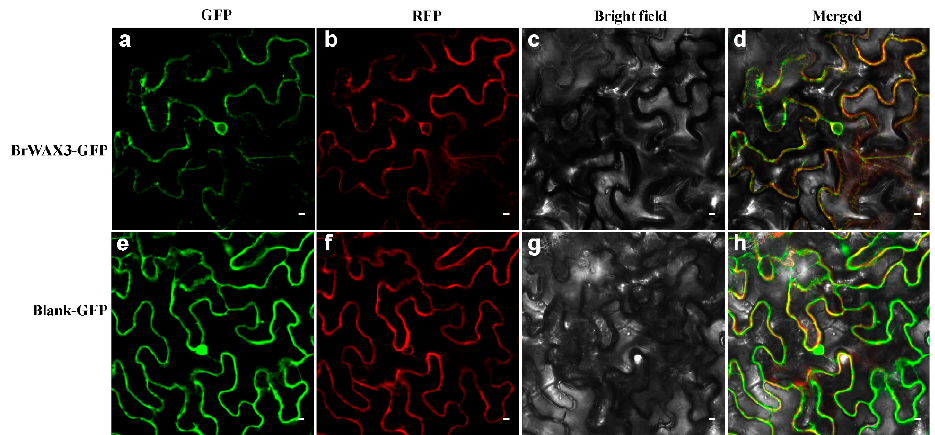
Figure 6. Subcellular localization analysis of BrWAX3 (BrCER60.A09). ( a , e ) The fusion construct BrWAX3-GFP ( a ) and the construct control ( e ) were transiently introduced into the tobacco leaf epidermal cells. ( b , f ) Fluorescence signals of an ER marker protein AtPIN5 fused with RFP. ( c , g ) Bright-field image. ( d , h ) Merged image of bright field and fluorescence.